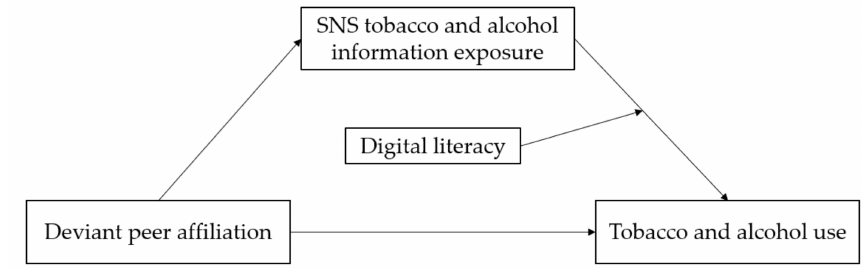
Figure 1. The constructed moderated mediating